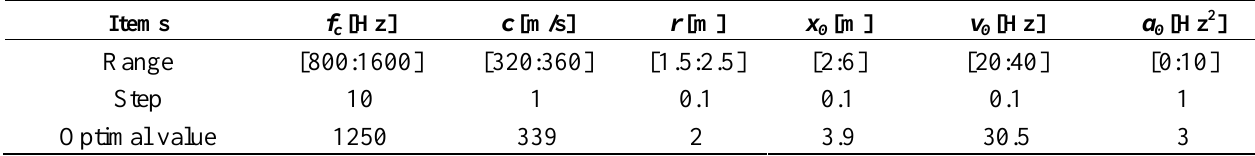
Table 4. Kinematic model parameter subsets and the optimal kinematic model parameters of the bearing signal with the out-race